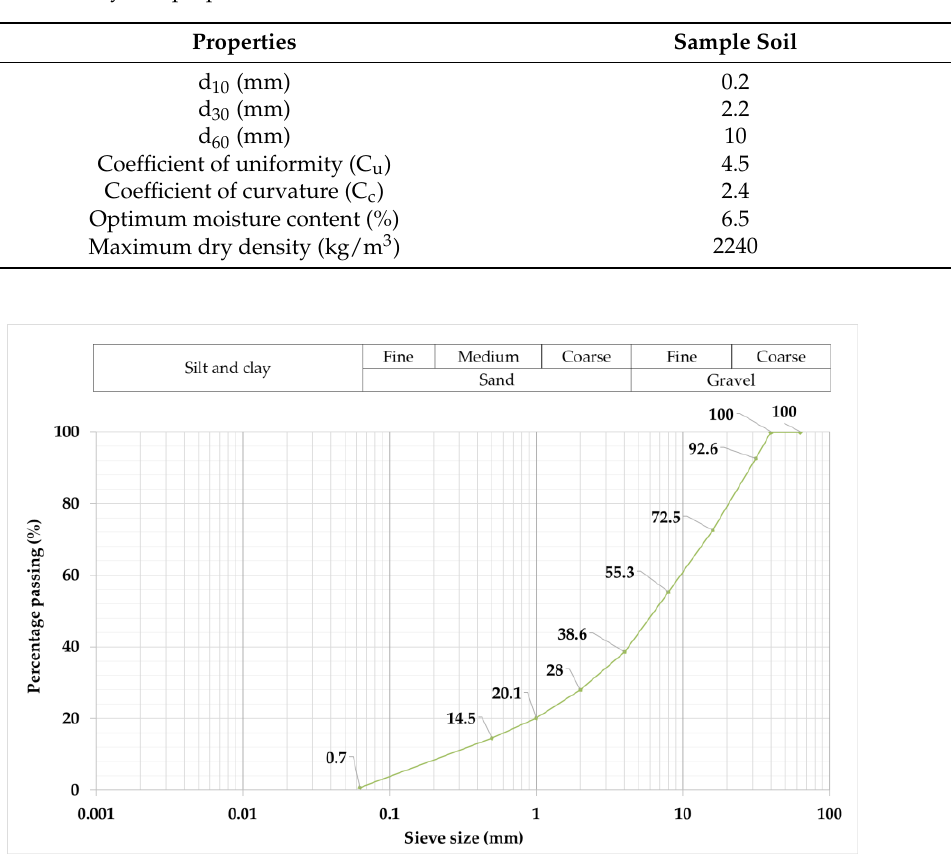
Table 2. Physical properties of the tested soil.